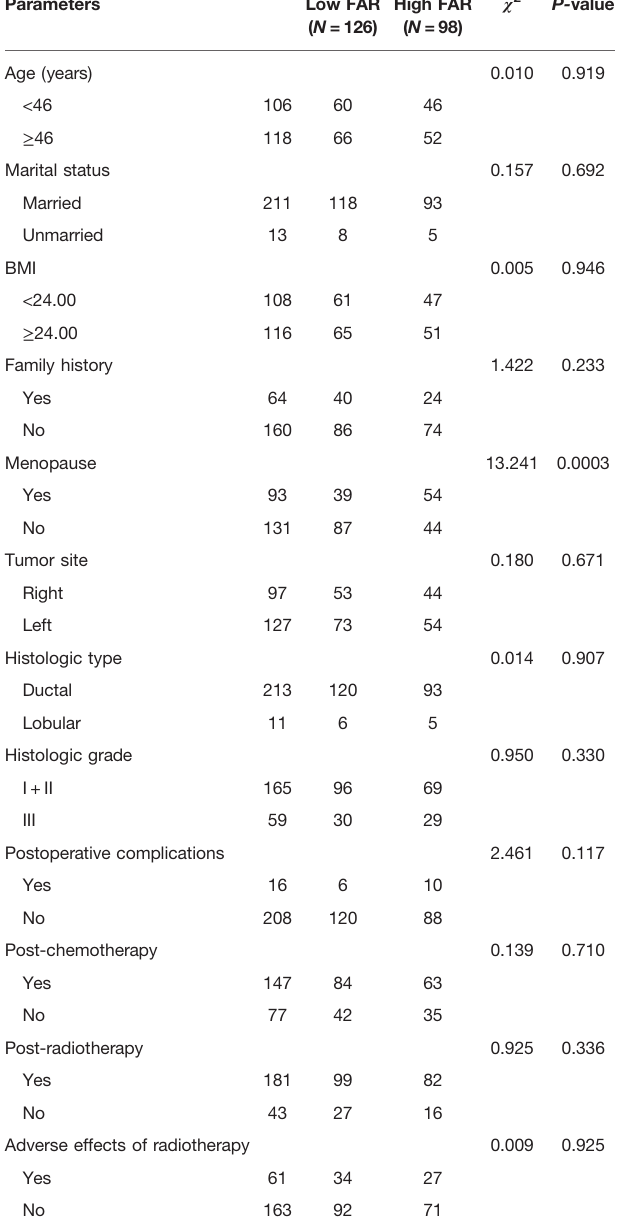
TABLE 1 | Demographic and clinicopathologic characteristics in triple- negative breast cancer.